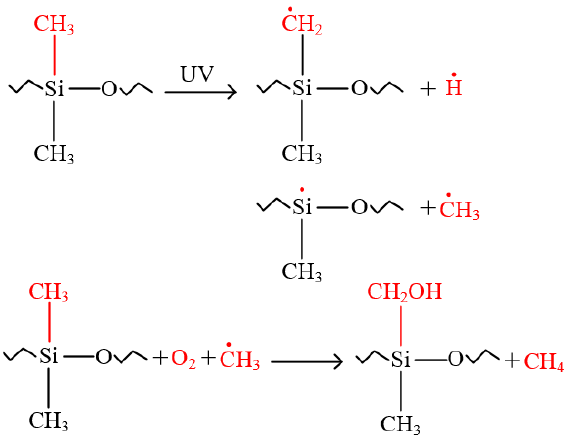
Figure 7. Chemical reactions in silicone rubber under UV irradiation [52] .